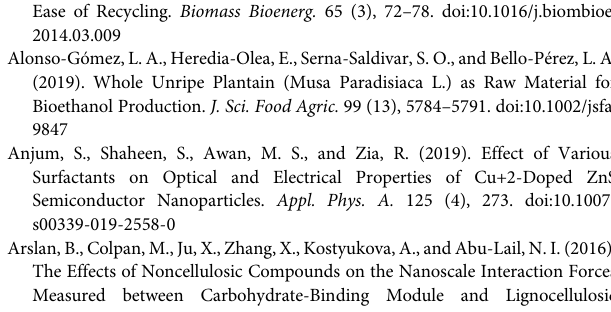
3 . This method can effectively prevent the ineffectiveness of cellulase immobilization. In this process, glutaraldehyde is used as the crosslinking agent, and EDC and are the coupling agents ( Figure 4 ). In the W/O system, the free carboxyl group (-COOH) in the adsorption zone of the cellulase molecules can realize covalent binding with a large number of amino terminal catalytic residues of chitosan molecules (Fan et al., 2016). The process cannot destroy the catalytic center of cellulase, and the exposed catalytic clefts increase the effective attachment of immobilized cellulase to solid substrates, which further promotes enzymatic